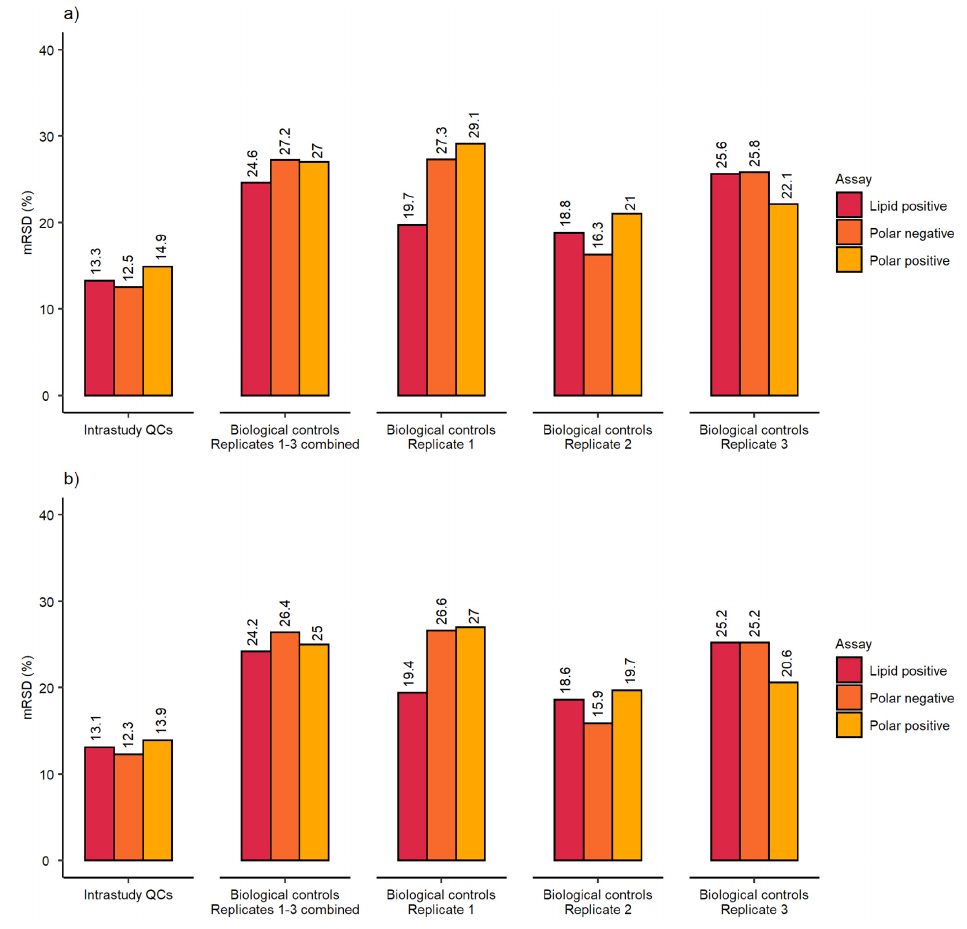
Figure 3. mRSD (%) of spectral feature intensities using control samples at 24 h from the high- throughput metabolomics study ( a ) before and ( b ) after RSD filtering for HepaRG control samples: n = 3 biological control replicates (here defined as replicates prepared across multiple weeks of cell culture), each measured as n = 9 technical replicates (here defined as replicates wells of cells cultured within the same test 96-well microplate).